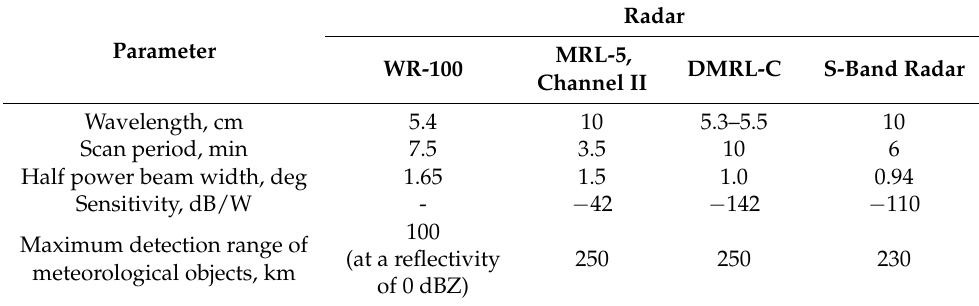
Table 1. Main parameters of the